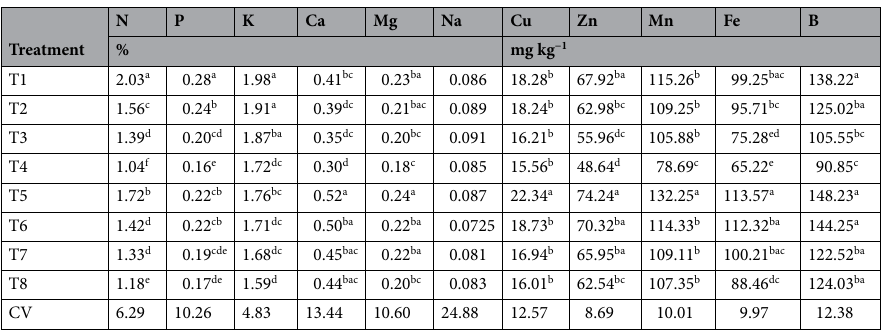
Table 1. King grass foliar content based on cutting days and fertilization. CV coefficient of variation. Measures in columns followed by different letters are significantly different (P < 0.05), based on Duncan’s multi-range test.